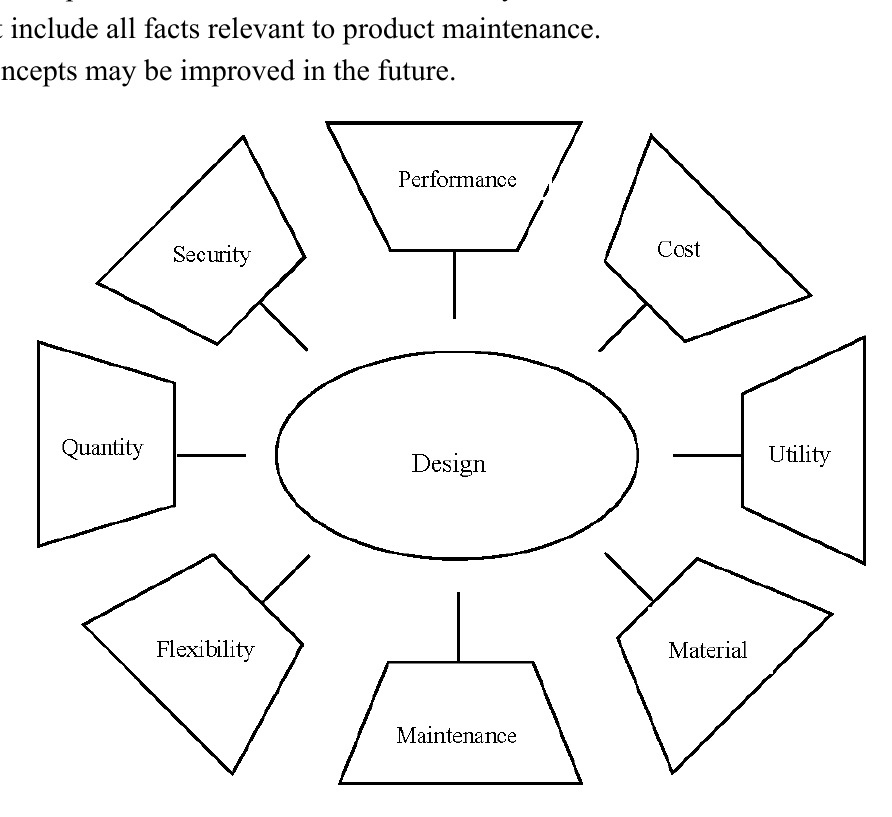
Figure 1. Design specifications of the shading